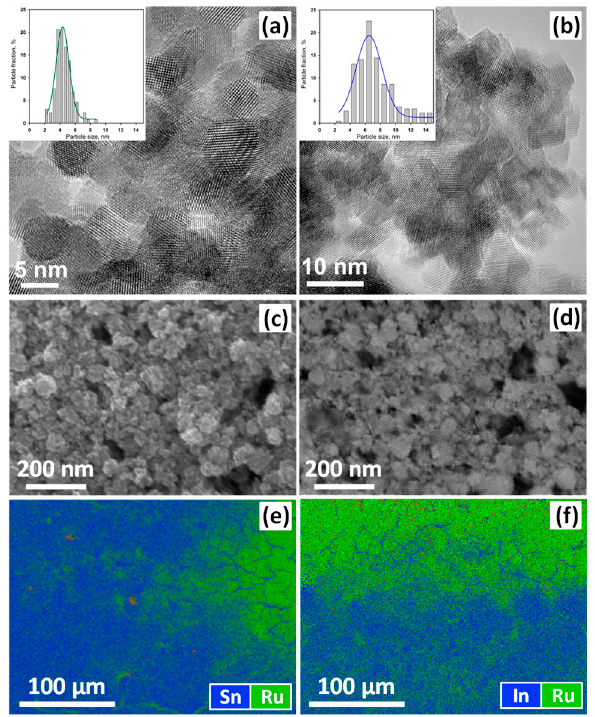
Figure 1. High resolution transmission electron microscopy (HRTEM) ( a , b ) images of SnO 2 ( a ) and In 2 O 3 ( b ) nanoparticles. SEM ( c , d ) images of SnO 2 ( c ) and In 2 O 3 ( d ) thick films deposited over functional substrates and sintered at 300 ◦ C. Energy dispersive X-ray spectroscopy (EDX) maps ( e , f ) of element distribution on the surface of the hybrid SnO 2 + RuITP ( e ) and In 2 O 3 + RuITP ( f ) thick